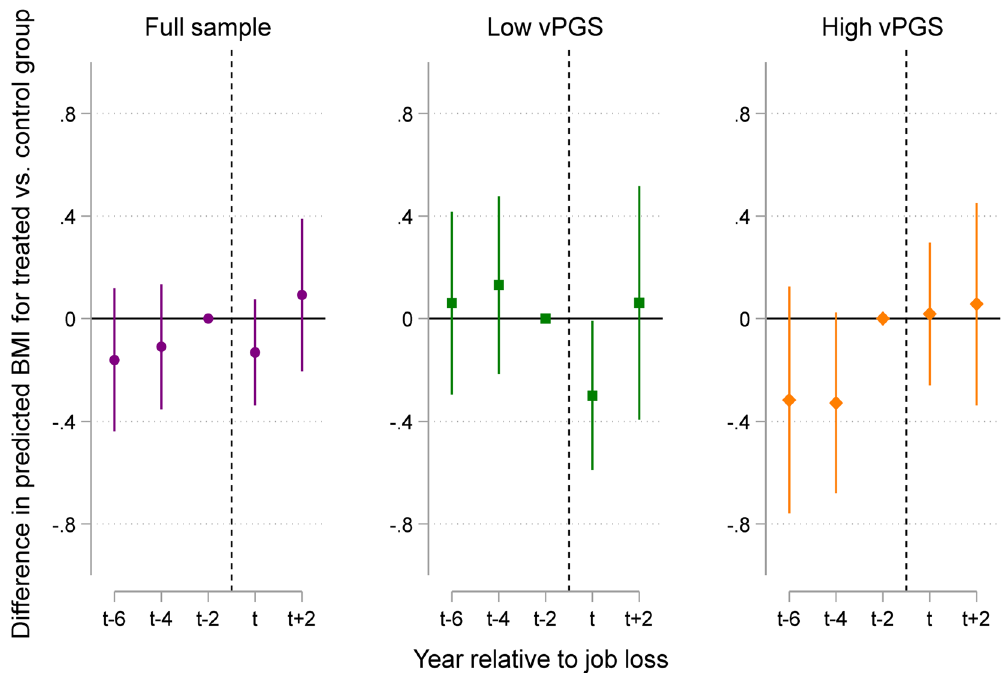
Figure 3. Difference in predicted BMI for treatment and control groups by the year relative to job loss for the entire analytic sample and stratified at the vPGS median. The figure plots the coefficients from an event time study model for the full sample and by samples stratified at the vPGS median (see Methods). The reference category is BMI in t − 2, or BMI at baseline before the job loss occurred for treated individuals. The dotted line depicts the approximate time point that the job loss occurred—i.e., at some point between t − 2 and the wave a job loss was reported, or time t. Error bars represent 95% confidence